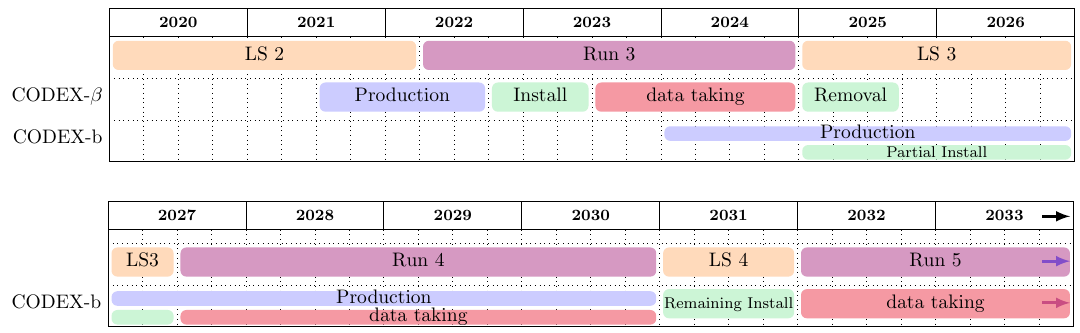
Fig. 4 Schematic summary of reach and coverage of various current, planned or proposed experiments in the LLP mass, lifetime, and